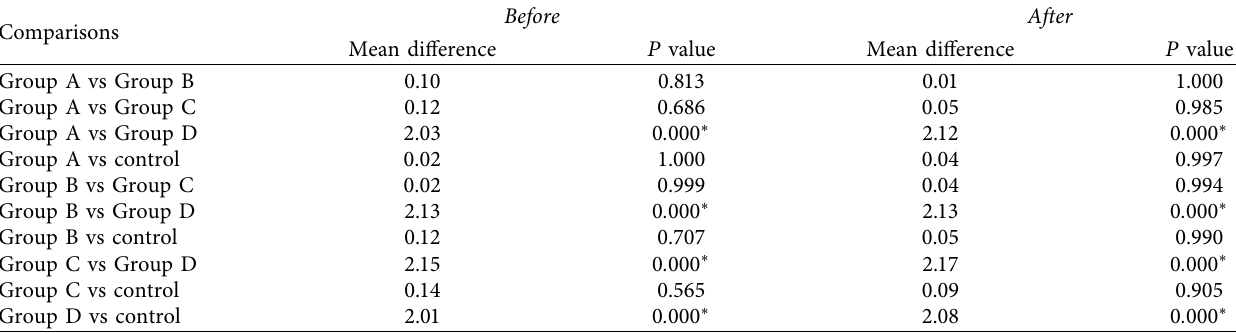
Table 2: Multiple comparison by Tukey Post Hoc test.